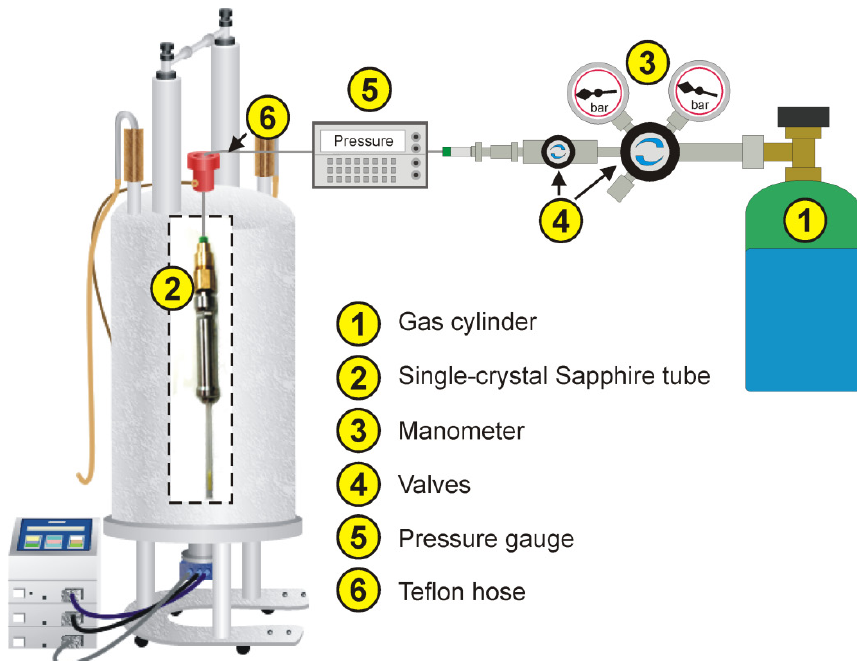
Figure 16. High-pressure apparatus for in situ NMR studies of gas adsorption. Reprinted with permission from [183]. Copyright 2011 American Chemical